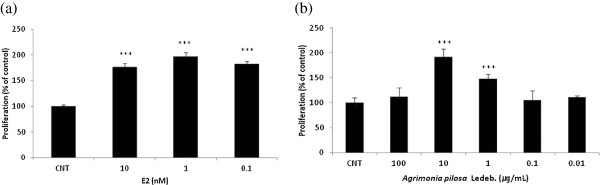
Effect of (a) E2 (17-β estradiol) and (b) aqueous extracts of A. pilosa on the proliferation of MCF-7 cells. Figures were selected as representative data from three independent experiments. Results are expressed as mean ± SD values. Statistical significance was determined using the Student’s t test. *** p < 0.001.